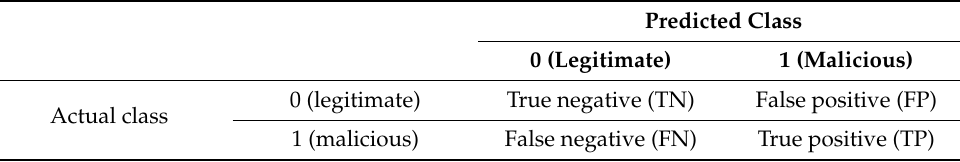
Table 1. Confusion matrix for malicious and legitimate